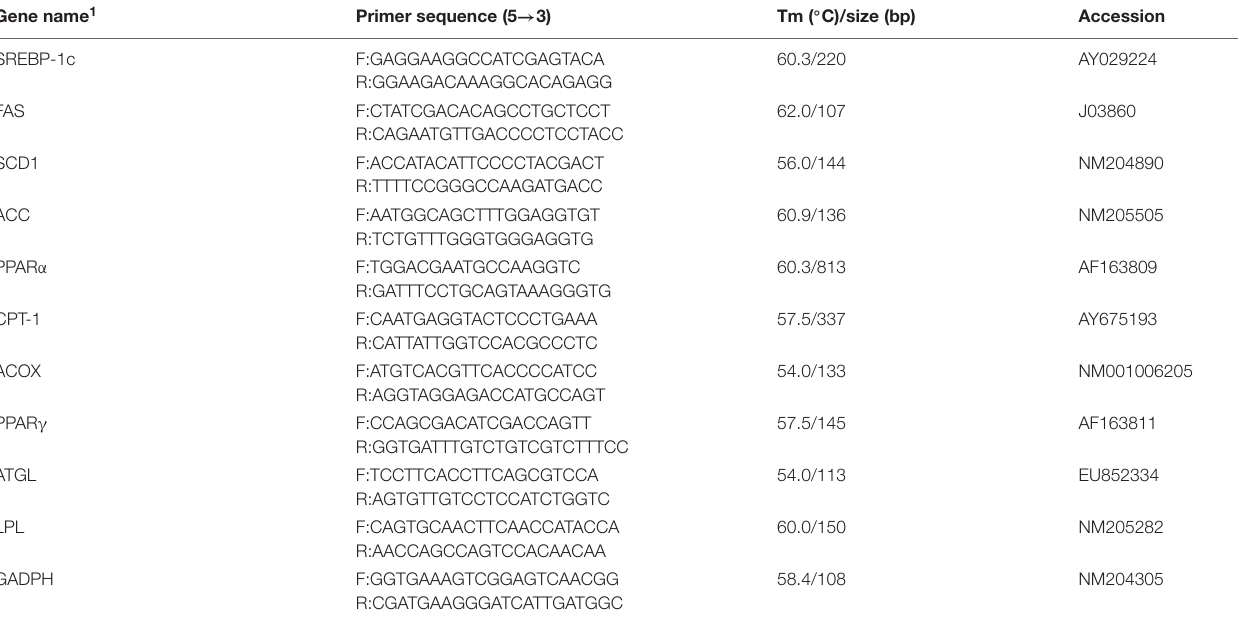
TABLE 2 | Gene-specific primers of lipid metabolism-related